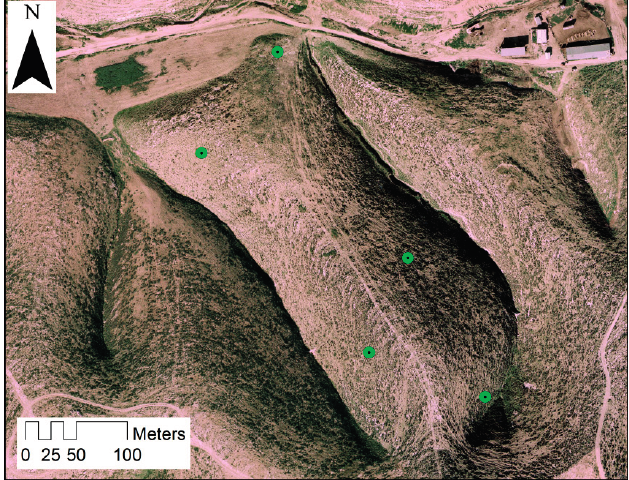
Figure A1. Hillslope locations where measured soil moisture data were compared to simulated 1D and 2D simulations.